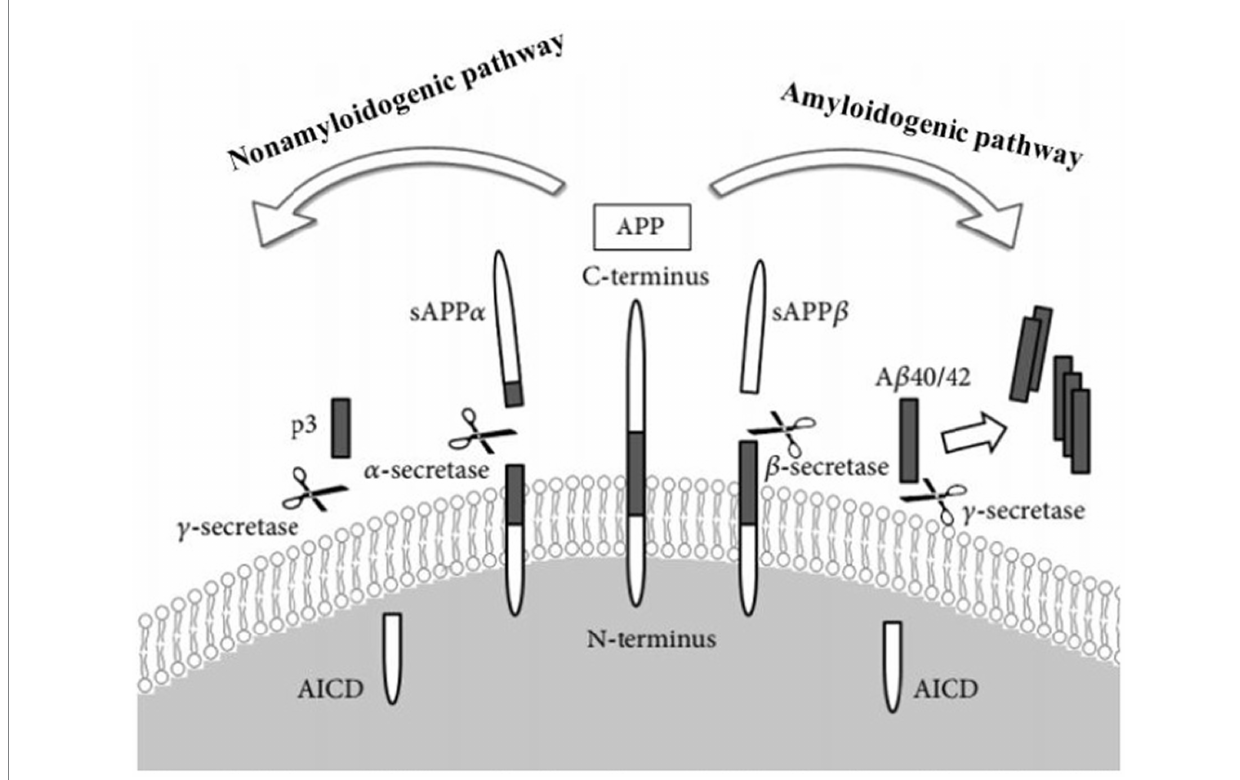
FIGURE 1 Beta-amyloid formation from the proteolytic digestion of the APP. AICD: APP intracellular C-terminal domain (Thinakaran and Koo, 2008).